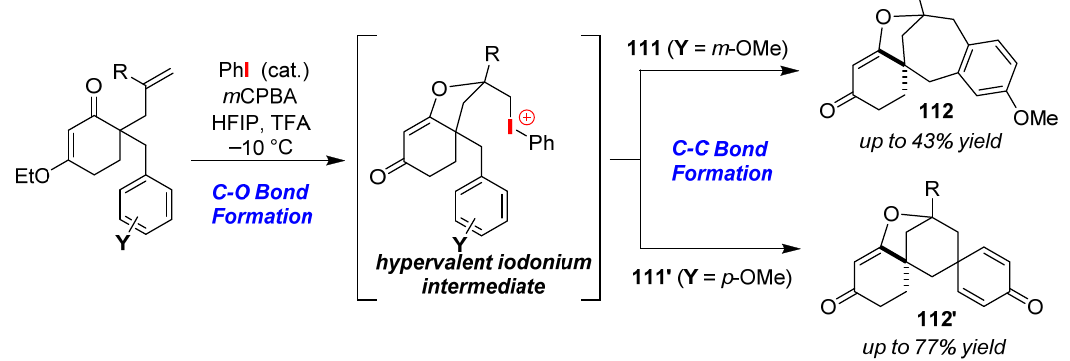
Figure 52. Selective synthesis of oxabicyclic [4.2.1]nonanes 112 and [3.2.1]octanes 112 ′ mediated by a hypervalent iodonium intermediate.